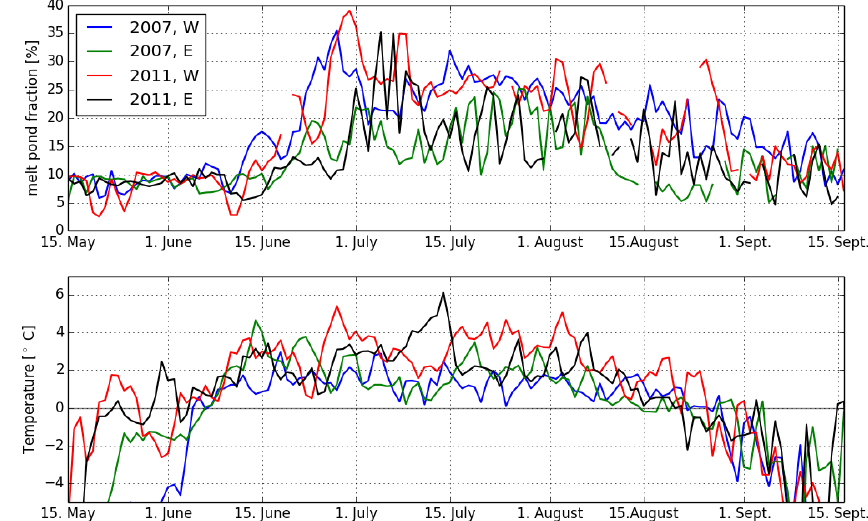
Figure 5. Daily averages of MPF (top panel) and NCEP air temperature at the surface (bottom panel) for two locations with the similar melt dynamics (“reference”) and diverse melt dynamics (“characteristic”): reference location to the north to the Queen Elizabeth Islands, 83 ◦ N, 110 ◦ W (tag “W” in the legend), 2007 (blue curves) and 2011 (red curves) and characteristic location in the Barents Sea, 85 ◦ N, 65 ◦ E (tag “E” in the legend), 2007 (green curves) and 2011 (black curves). Locations are shown in Fig. 1.